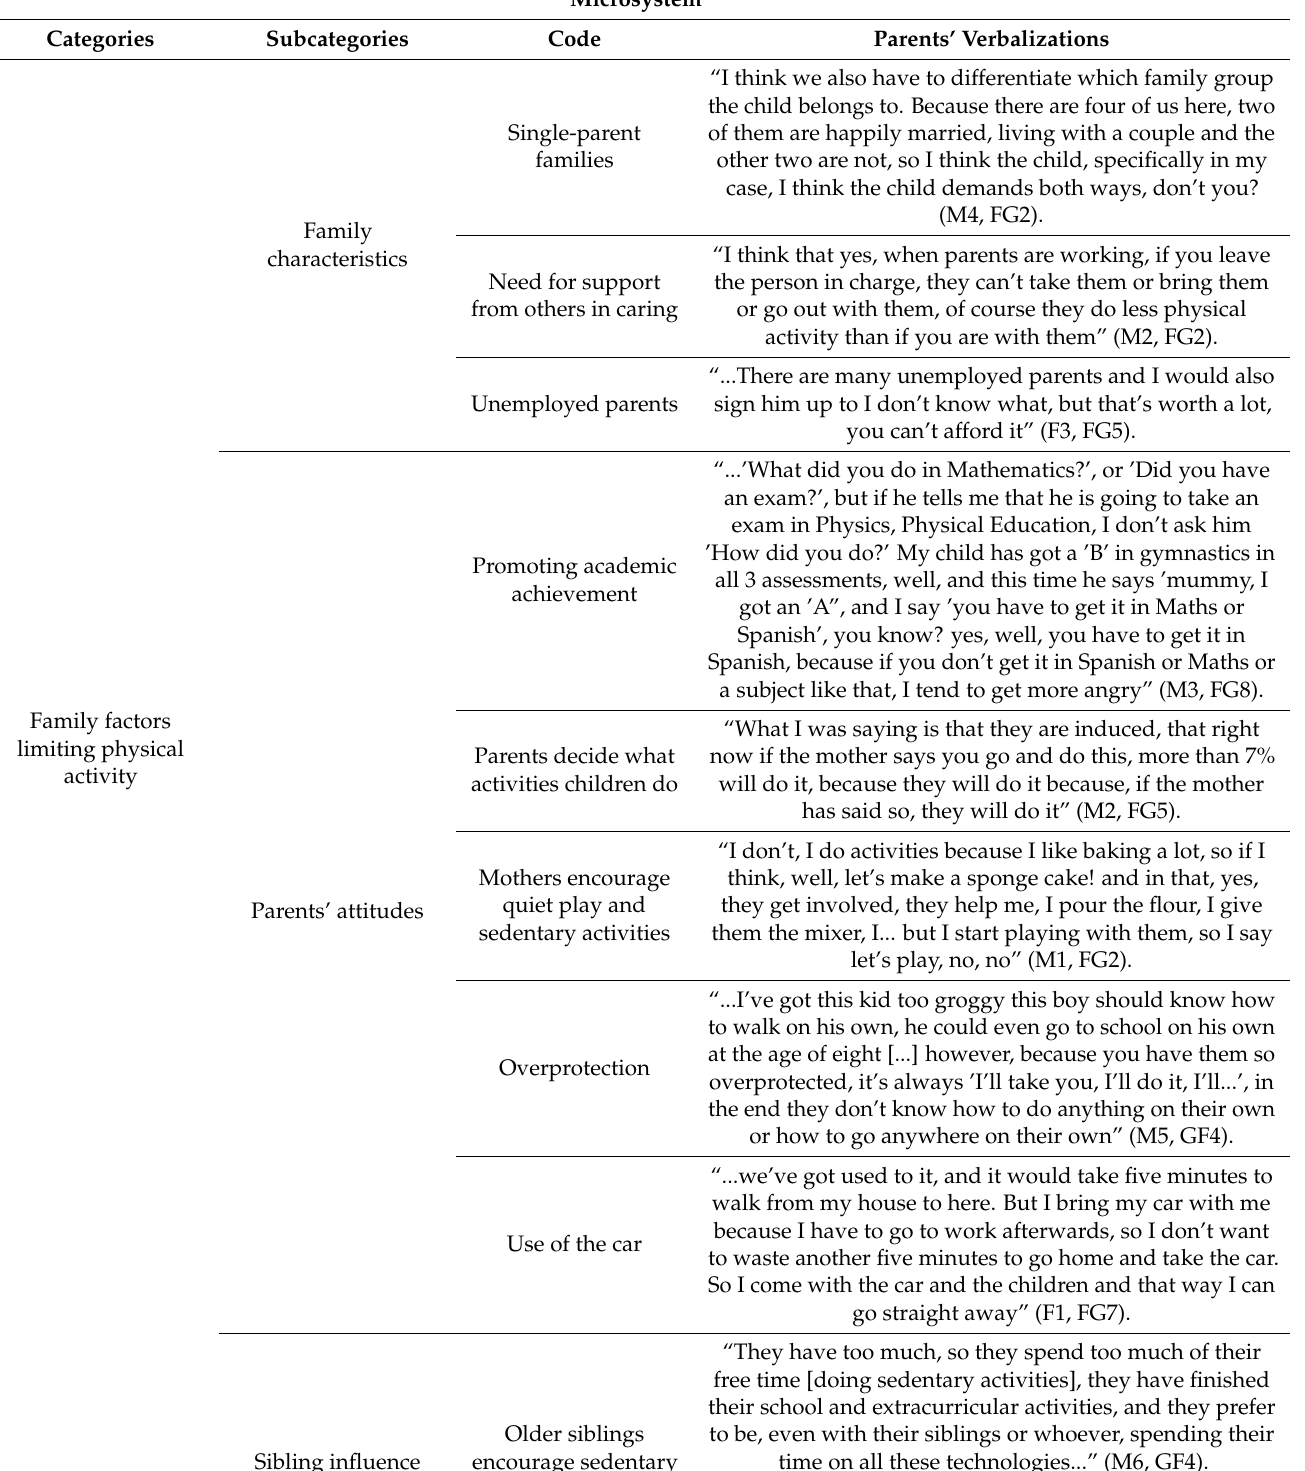
Table 4. Microsystem barriers to physical activity for